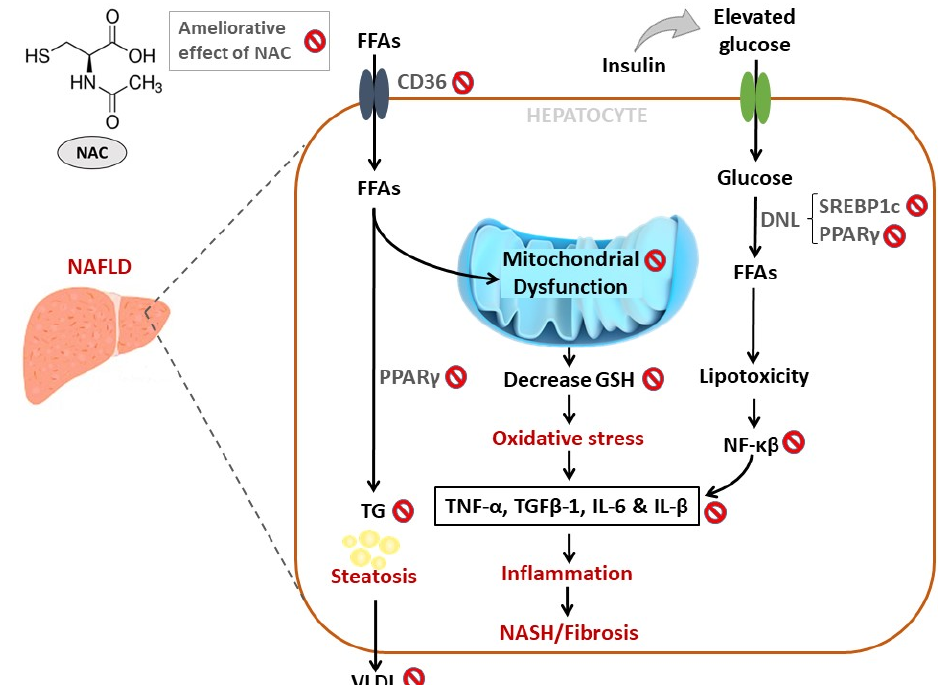
Figure 3. An overview of therapeutic mechanisms linked with the ameliorative effect of n-acetyl cysteine (NAC) against the complications involved in the development of non-alcoholic fatty liver disease (NAFLD). In brief, NAC blocks hepatic lipid accumulation in part through the effective regulation of transcriptional factors such as sterol regulatory element-binding protein (SREBP)-1c/-2 and peroxisome proliferator-activated receptor gamma (PPAR γ ) in preclinical models of NAFLD. Importantly, NAC appears effective in improving liver function by reducing pro-inflammatory markers such as interleukin (IL)-6, IL-1 β , tumour necrosis factor alpha (TNF- α ), transforming growth factor beta (TGF β )-1 and nuclear factor kappa-light-chain-enhancer of activated B cells (NF- κ B). This was primarily through the attenuation of lipid peroxidation, improvements in mitochondrial function, and enhancements in intracellular response antioxidants, particularly glutathione (GSH). Abbreviations: TG = triglycerides; DNL = de novo lipogenesis.